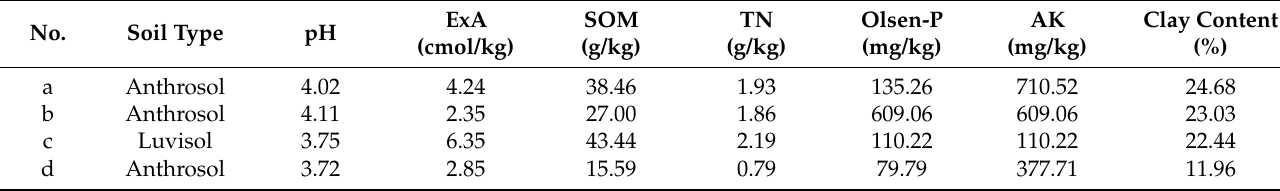
Table 1. Basic chemical properties of the test